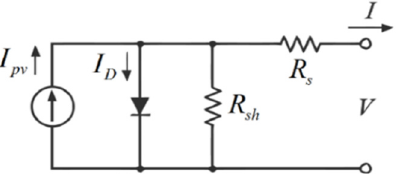
Figure 2. Equivalent circuit model of a PV cell.